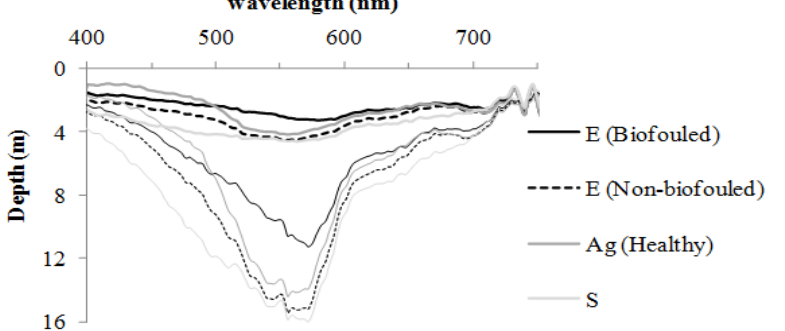
Figure 5. The depth at which the HyperSAS sensor can no longer distinguish each substrate from optically deep water for the lowest (thin lines) and highest (thick lines) K found at the study site. Calculated as per [19]. Refer to Figure 2 for high and low K